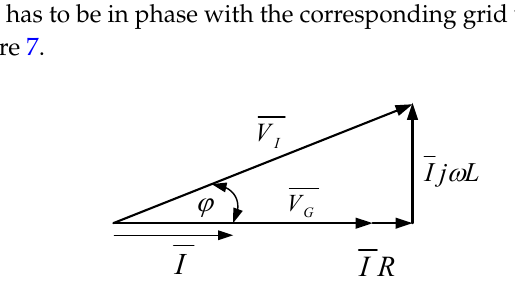
Figure 7. Phasor diagram for maximum transferred power.